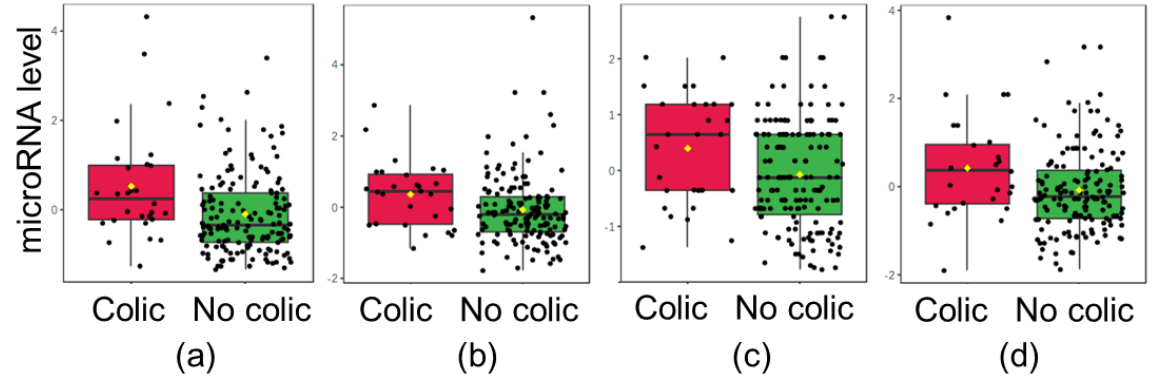
Figure 5. Levels of four miRNAs in human milk differ among mothers of infants with colic. Mann– Whitney testing revealed higher levels of ( a ) miR-224-3p ( p = 0.0038, adj. p = 0.023, d = 0.33), ( b ) miR-125b-5p ( p = 0.010, adj. p = 0.028, d = 0.29), ( c ) let-7a-5p ( p = 0.018, adj. p = 0.028, d = 0.27), and ( d ) miR-205-5p ( p = 0.019, adj. p = 0.029, d = 0.26) in the milk from mothers of infants with colic (red), compared to milk from mothers of infants without colic (green). Quantile normalized levels from RNA sequencing are displayed, with mean (yellow diamond), median (black bar), and standard deviation.